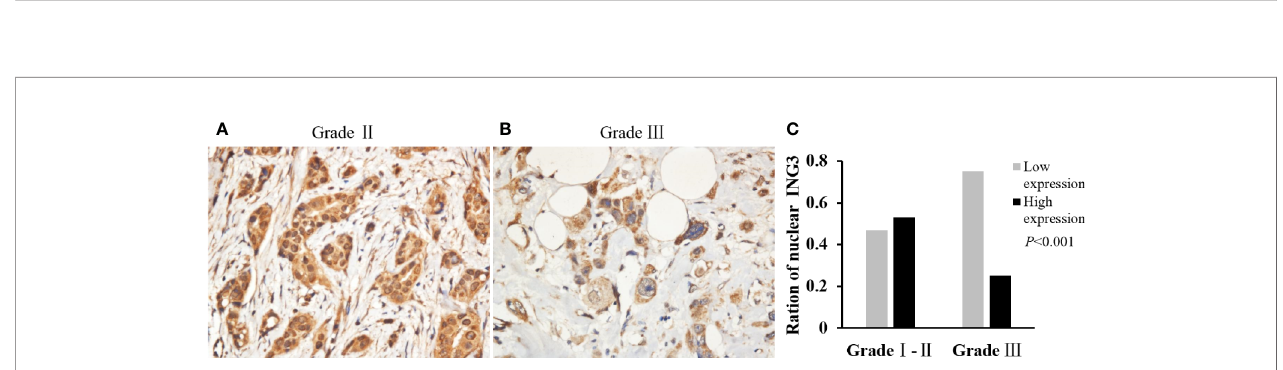
FIGURE 1 | The expression and distribution of ING3 in representative tissue specimens. (A) The expression of ING3 in normal breast tissues. (B) Negative nuclear ING3 staining in breast cancer tissues. (C) Moderate nuclear ING3 staining in breast cancer tissues. (D) Strong nuclear ING3 staining in breast cancer tissues. (A – D) Magni fi cation, ×200. (E) The summary of nuclear ING3 staining in breast cancer tissues and normal breast tissues. The intensity of nuclear ING3 expression in breast cancer tissues and normal breast tissues are indicated as follows: Low expression (light gray) and High expression (black). The expression of nuclear ING3 are signi fi cantly decreased in breast cancer tissues ( P < 0.001).